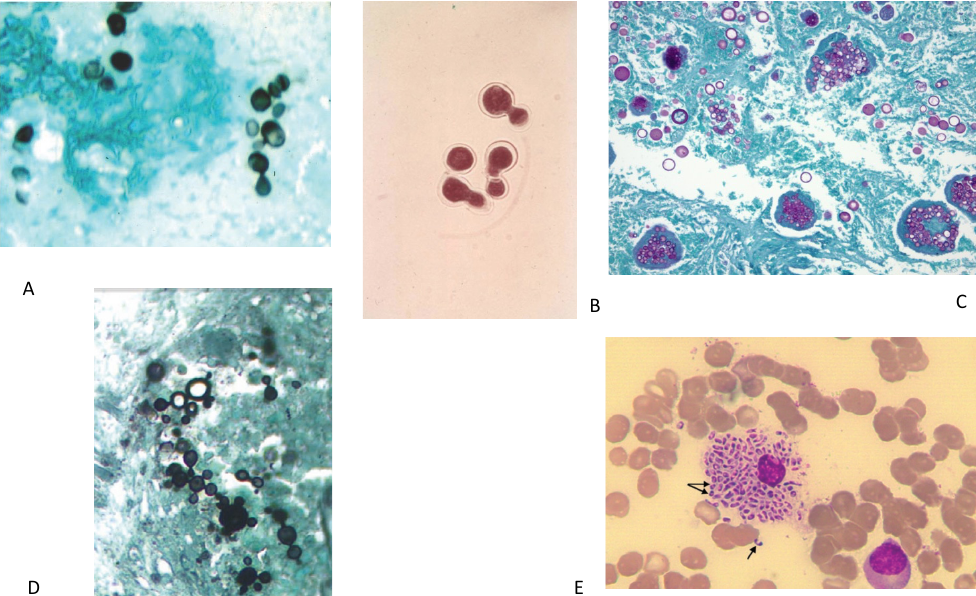
Figure 1. ( A ) Gomori methenamine silver stain showing small oval budding yeast form of H. capsulatum yeast. ( B ) KOH wet mount showing B. dermatitidis yeast with characteristic broad-based budding. ( C ) PAS stain C. immitis/posadasii endospore containing spherules with round thick walls in the tissue. Figure 1A–C from Wheat LJ, Goldman M, Hage CA, Knox KS, Cryptococcosis and the Endemic Mycoses In: Grippi MA, Elias JA, Fishman JA, Kotloff RM, Pack AI, Senior RM, Siegel MD, Fishman’s Pulmonary Diseases and Disorders . 5th ed. McGraw-Hill Education: 2015. Figure 134-3 [131]. ( D ) Typical multi-budding yeast cells (black staining) with a ‘ships-wheel’ appearance in a tissue sample of Paracoccidioides